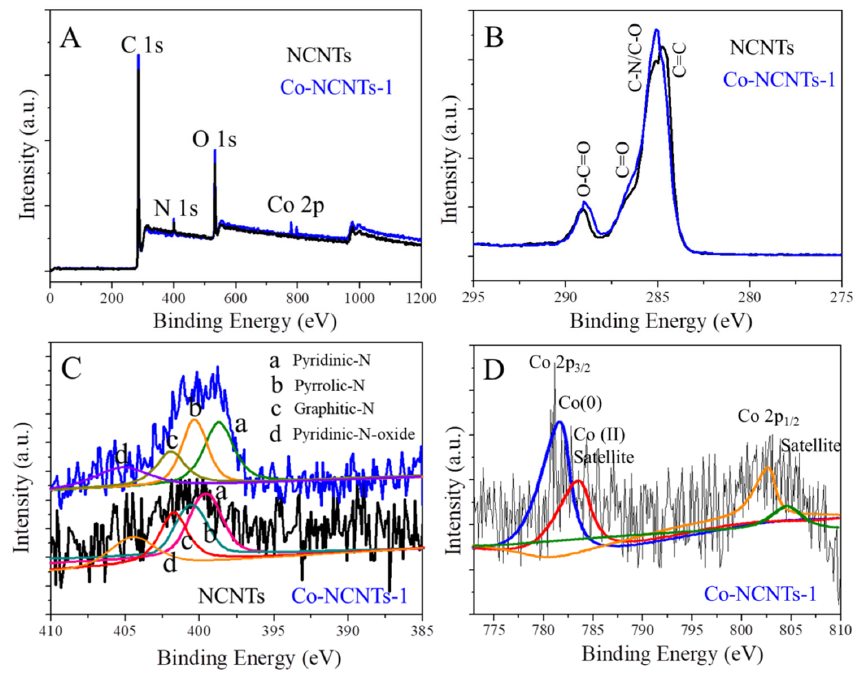
Figure 4. ( A ) XPS survey spectra of NCNTs and Co@NCNTs − 1; ( B ) high resolution XPS spectra of C 1s ( B ), N 1s ( C ), C ( D ) and Co 2p